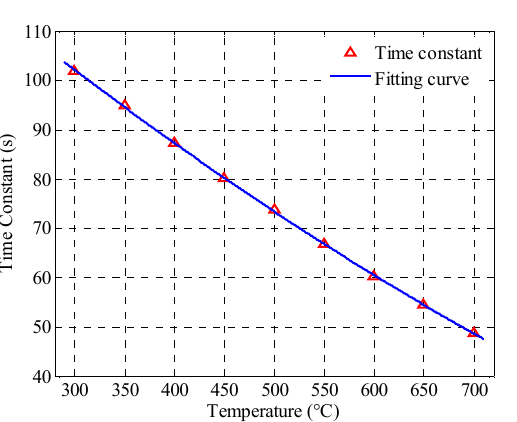
Figure 10. Curve of time constant and the temperature of high temperature furnace.